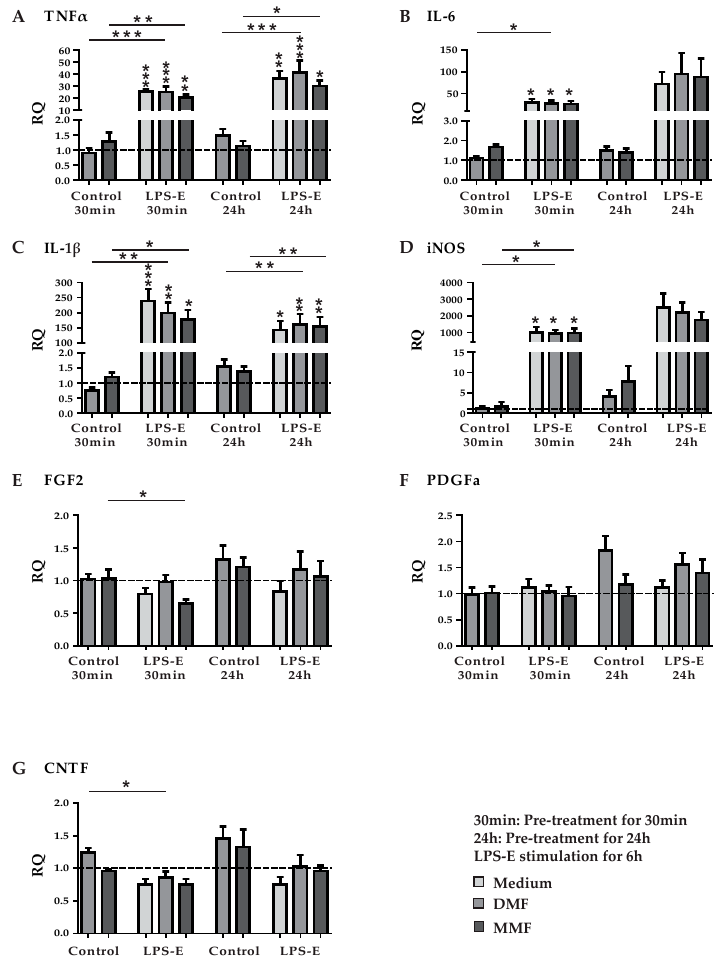
Figure 4. Gene expression of pro-inflammatory cytokines and growth factors in astrocytes pre-treated with DMF or MMF and stimulated with LPS. Astrocytes were pre-treated with medium, 10 µ M DMF or 10 µ M MMF for 30 min or 24 h and afterwards stimulated with 10 ng / mL LPS-E (lipopolysaccharide from Escherichia coli 055:B5). Graphs show mRNA expression fold changes of TNF α ( A ), IL-6 ( B ), IL-1 β ( C ), iNOS ( D ), FGF2 ( E ), PDGFa ( F ) and CNTF ( G ) compared to the control group (astrocytes only treated with medium) and normalized with HPRT-1 using the ∆∆ CT method. Data are presented as the arithmetic means ± SEM of n = 4. Significant differences are marked by asterisks (* p < 0.05; ** p < 0.01; *** p < 0.001).